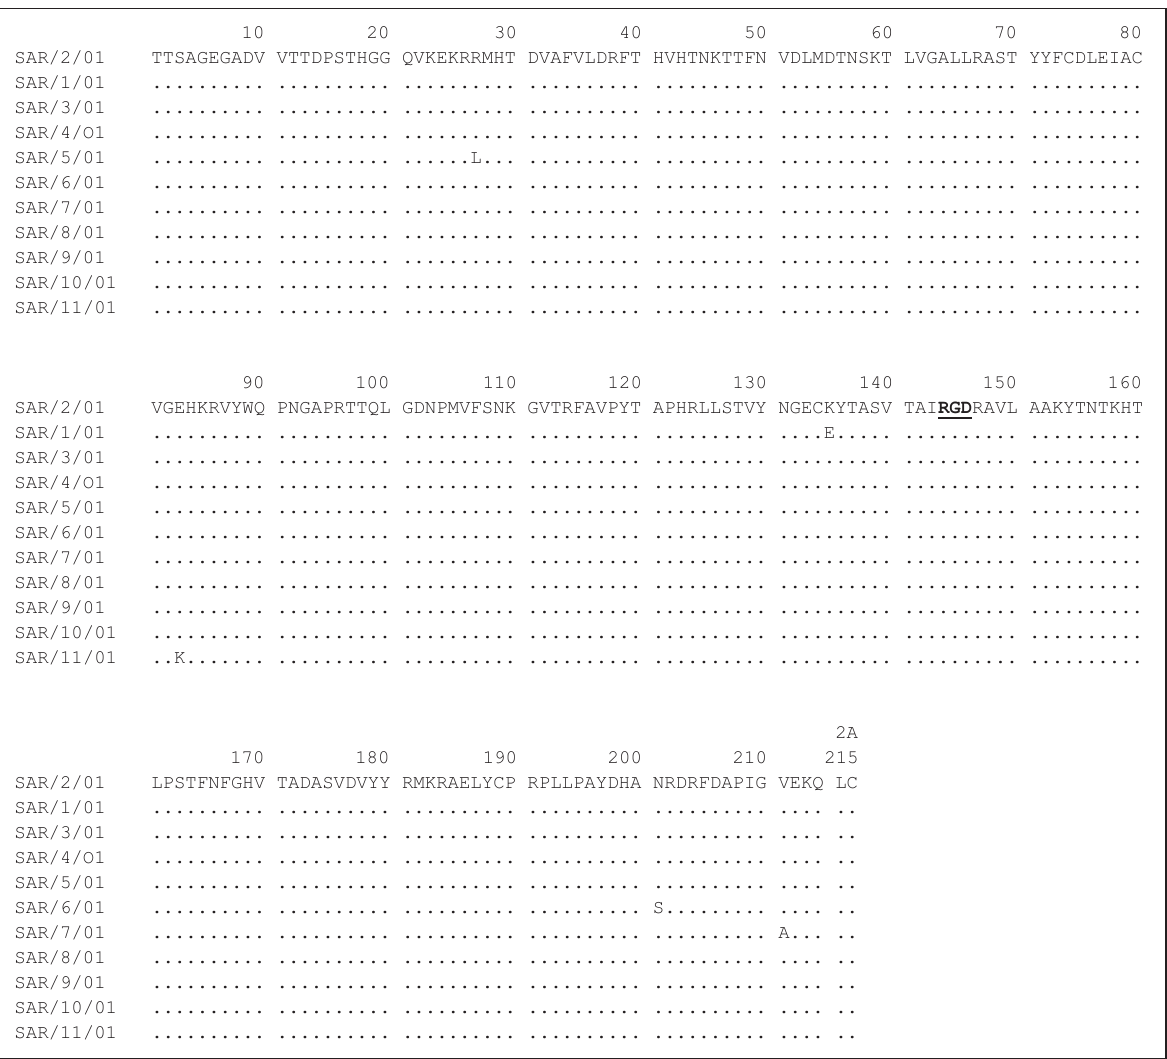
FIG. 2 Sequence alignments of 216 amino acids corresponding to the 1D/2A gene of the 11 SAT-2 outbreak strains obtained during a single outbreak that affected various farms during 2001. Cell attachment site of the viruses (RGD), in the G-H loop is highlighted and underlined. ‘ .’ indicates amino acids identical to